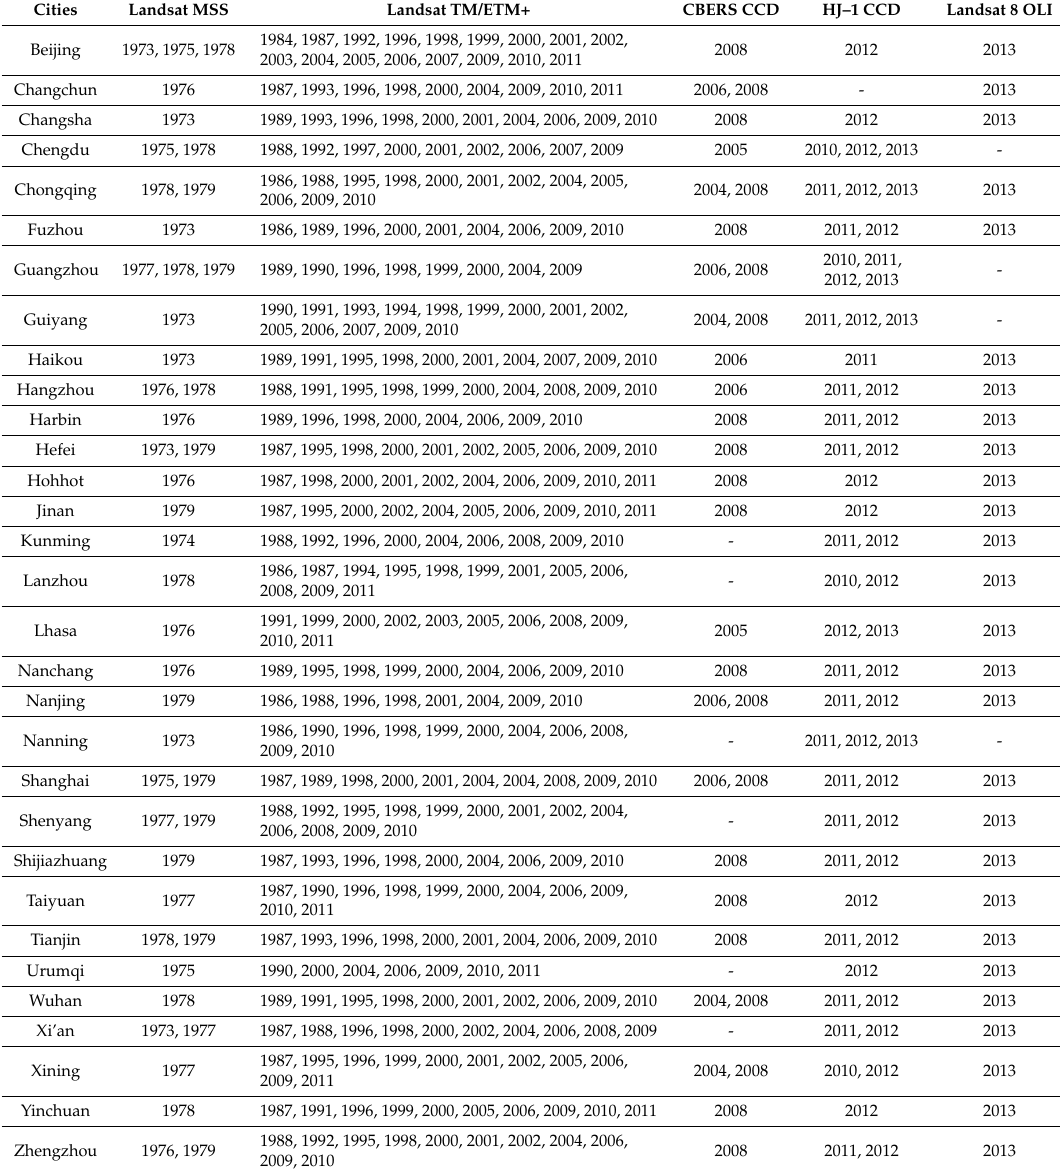
Table A1. Image source, year, and sensor of the 31 sample